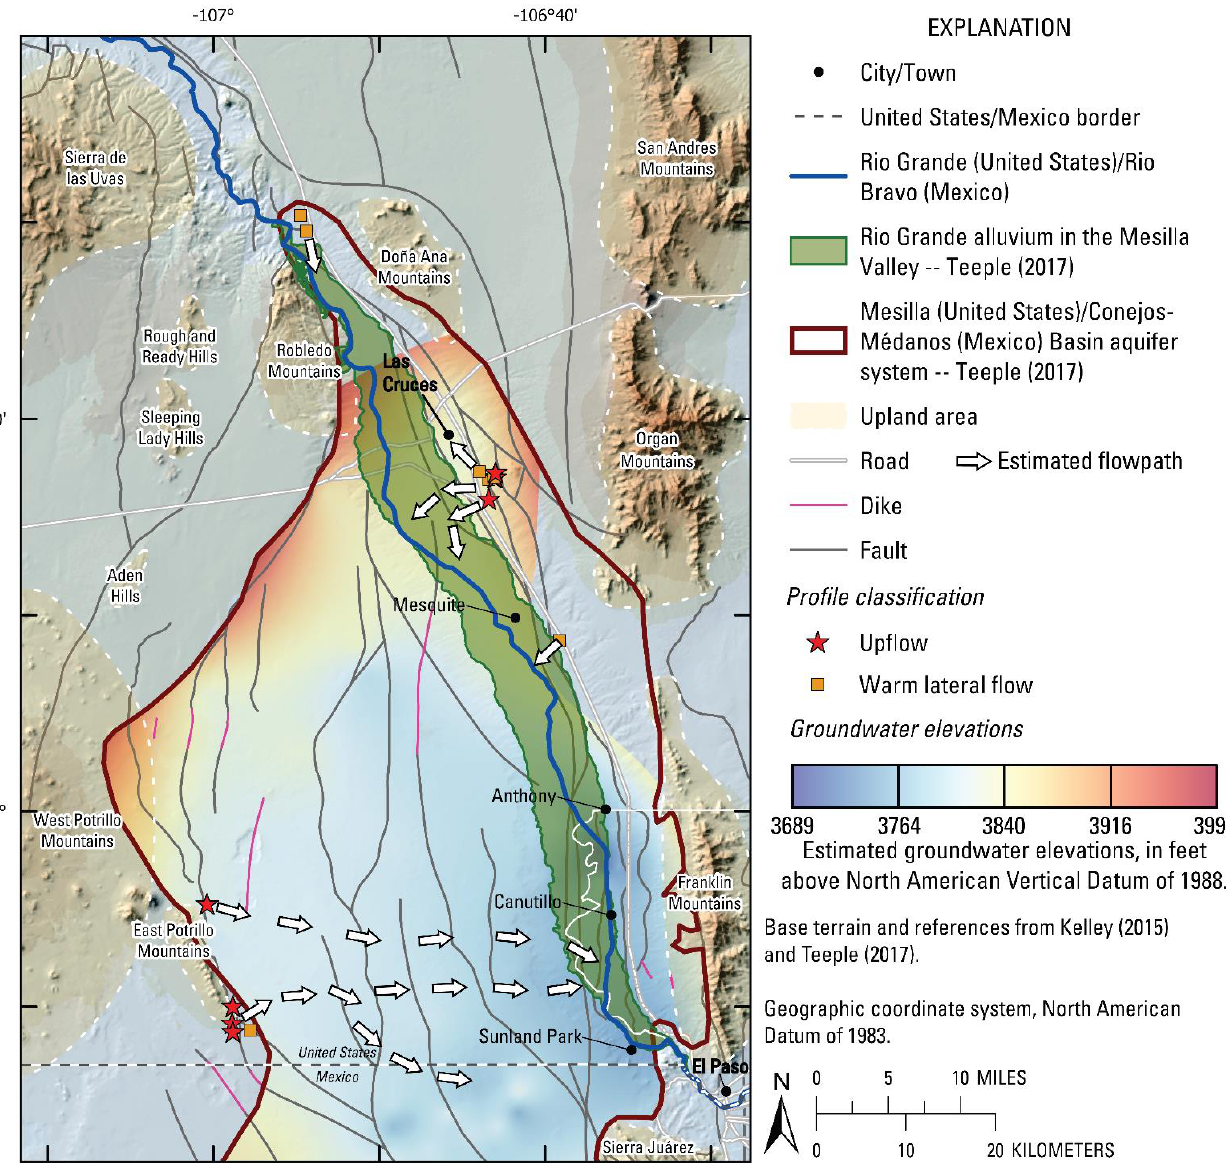
Figure 7. Anticipated flow patterns of upwelling and warm lateral flowing groundwater, as informed by groundwater-elevation mapping from Robertson et al. (2021) [20–22]. Estimated flowpath arrows are oriented perpendicularly to groundwater elevation contours with flow directed down hydraulic gradient. Groundwater elevations depict groundwater flow towards the Rio Grande and southern Mesilla, along with flow intercepted by groundwater wells in Las Cruces and northern